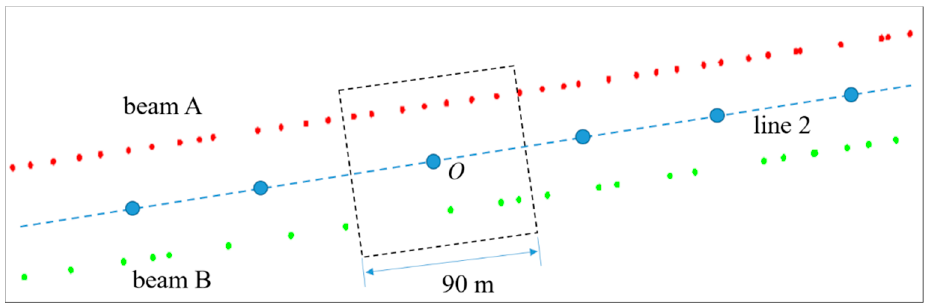
Figure 3. Schematic diagram of slope estimation based on plane fitting of ground track pairs.